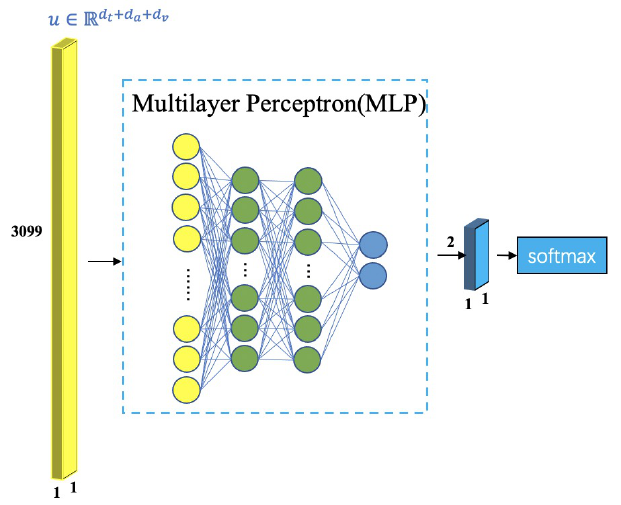
Figure 5. Multilayer perceptron block diagram. It consists of a three-layer fully connected neural network. The number of neurons in the input layer and output layer is 3099 and 2, respectively, and the number of neurons in the hidden layer is